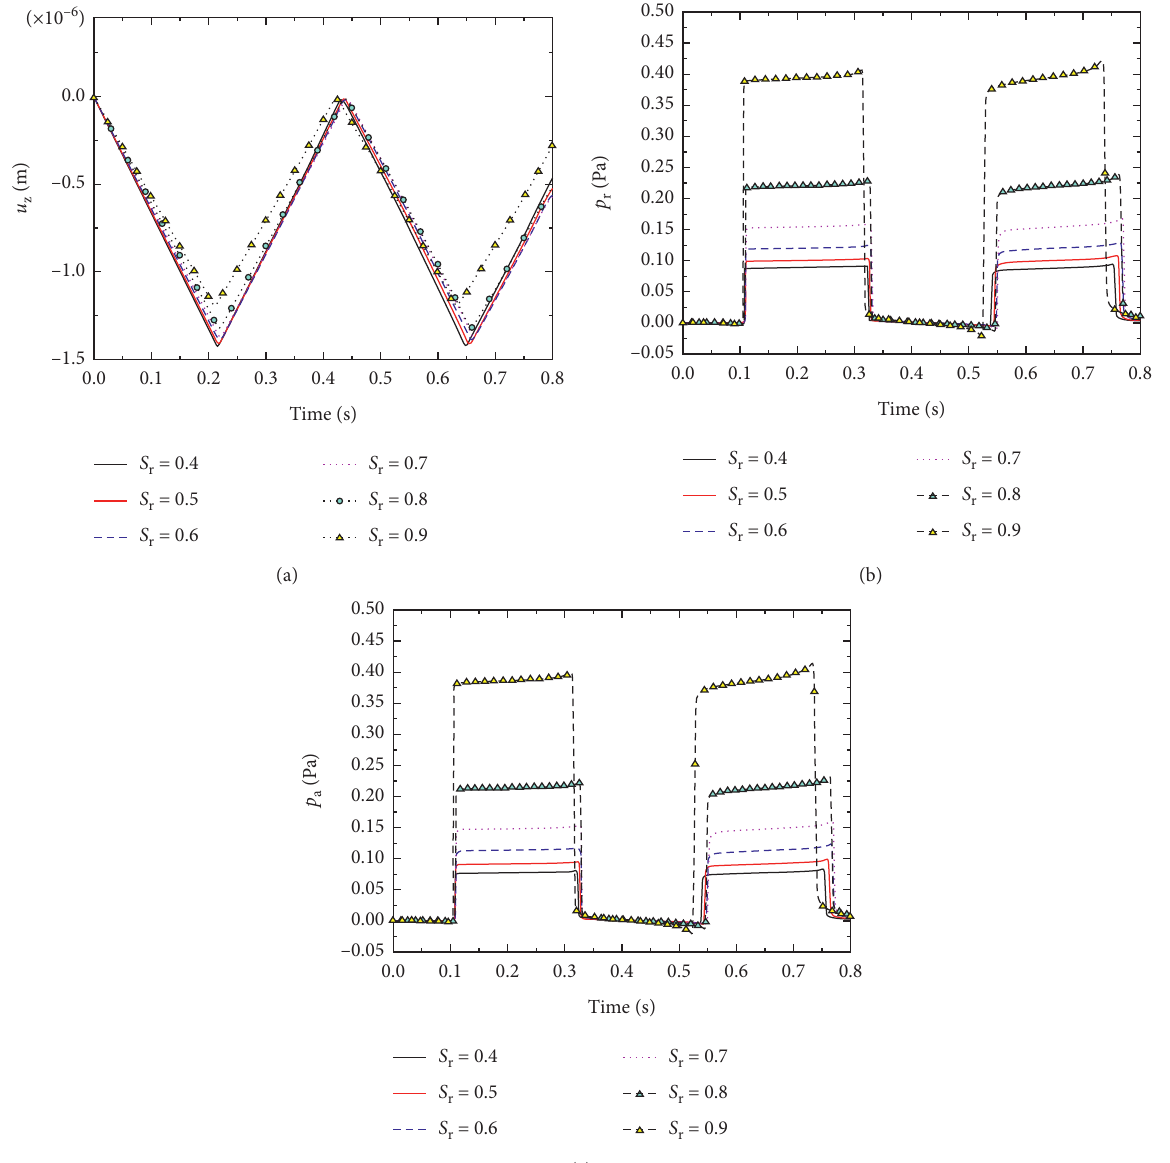
� L ), fluid pressure p � 0), and air pressure p � 0) with time z ( t , z f ( t , z a ( t , z